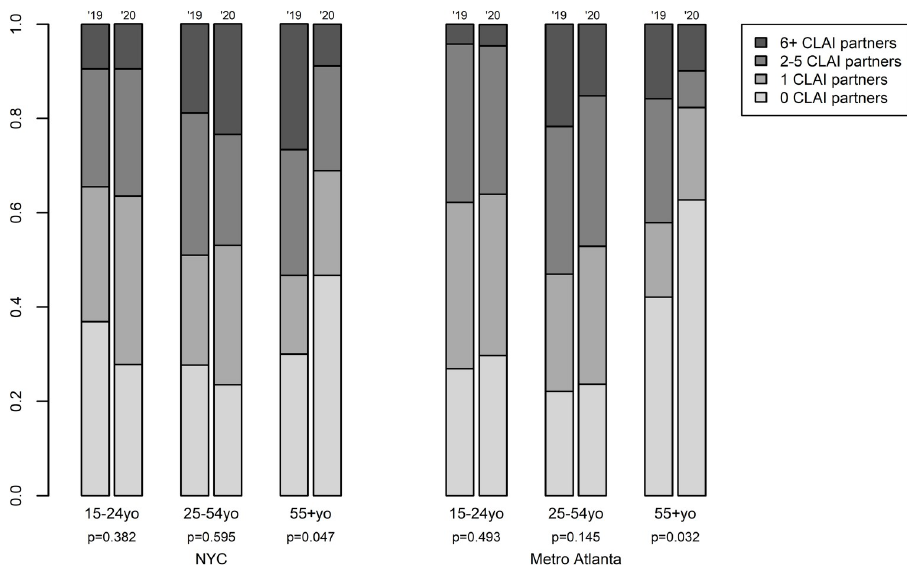
Fig 6. Number of condomless anal intercourse (CLAI) partners in the last 12 months, by year, city and age. Left- hand columns per pair = data from the 2019 round of AMIS; right-hand columns per pair = data from the 2020 round of